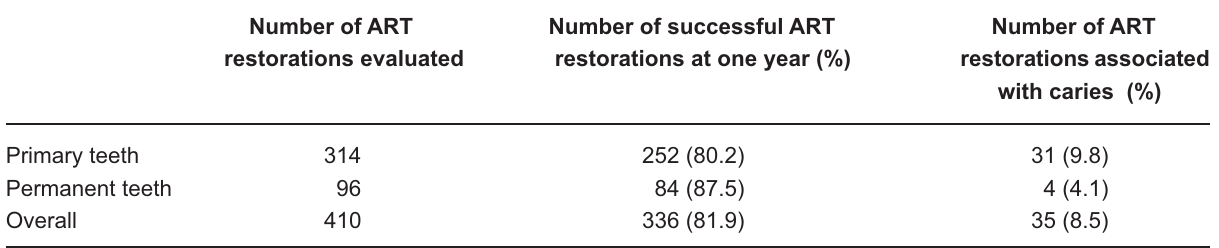
Table 1- Survival of ART restorations and those associated with caries at the one-year